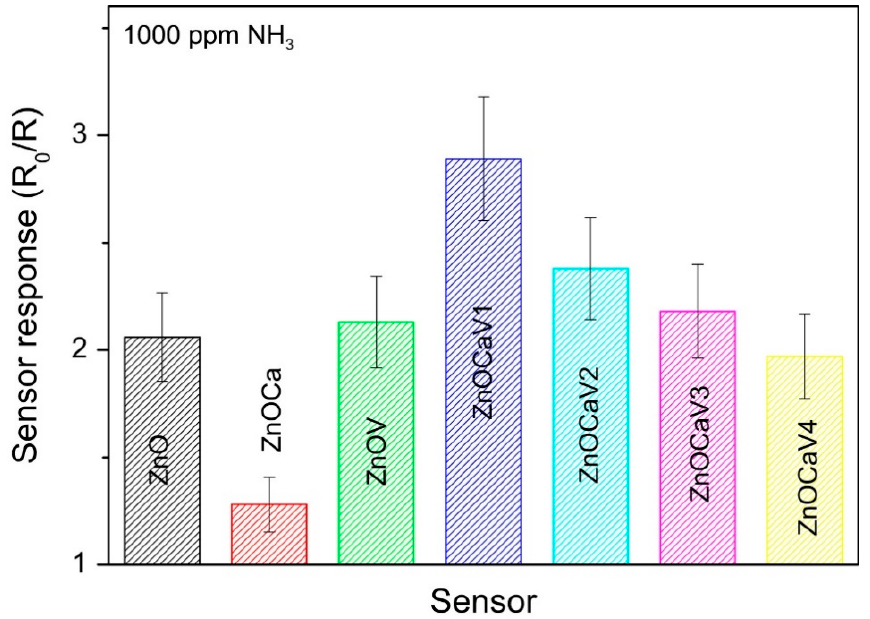
Figure 5. Detection response of 1000 ppm of ammonia for the investigated sensors. Reprinted from Journal of Solid State Chemistry, Vol 226, Fazio E. et al., Ammonia sensing properties of V-doped ZnO:Ca nanopowders prepared by sol–gel synthesis, Pages No. 192–200, Copyright (2015), with permission from Elsevier [67].